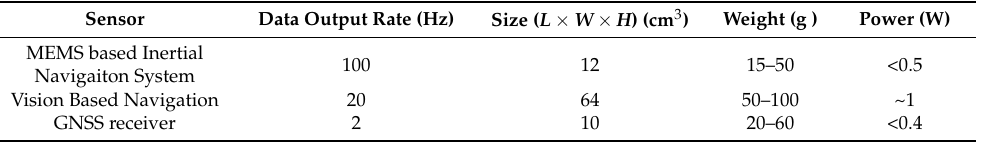
Table 5. Transport grade COTS Navigation sensor characteristics